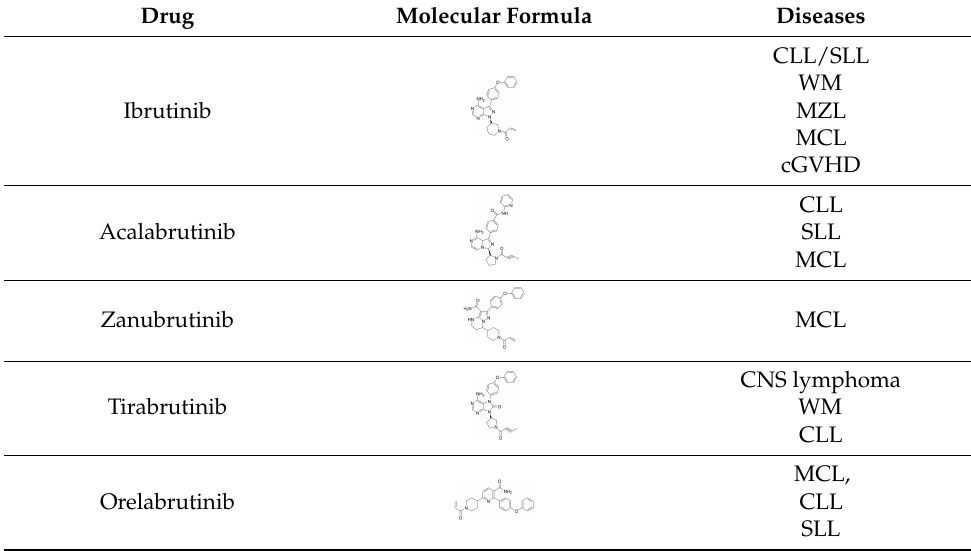
Table 1. Name, chemical structure and treated diseases of approved BTKIs.